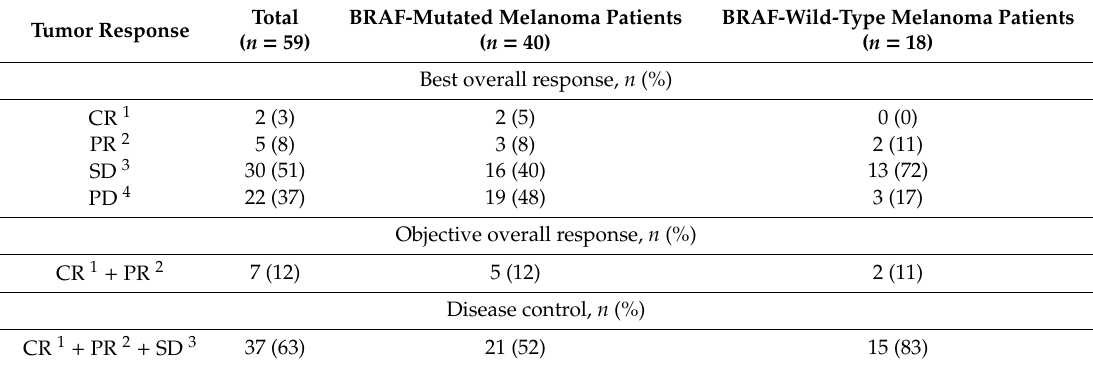
Table 4. Tumor response in BRAF-mutated or BRAF-wild type